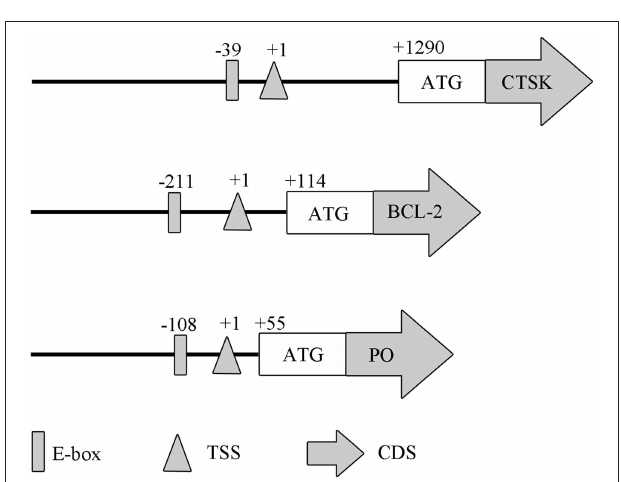
FIGURE 2 | Domain architectures of the MpPO , MpCTSK, and MpBCL-2 promoters, predicted using their promoter sequences. The positions of the E-box, transcription start site (TSS), initiation codon (ATG), and coding sequence (CDS) are annotated.